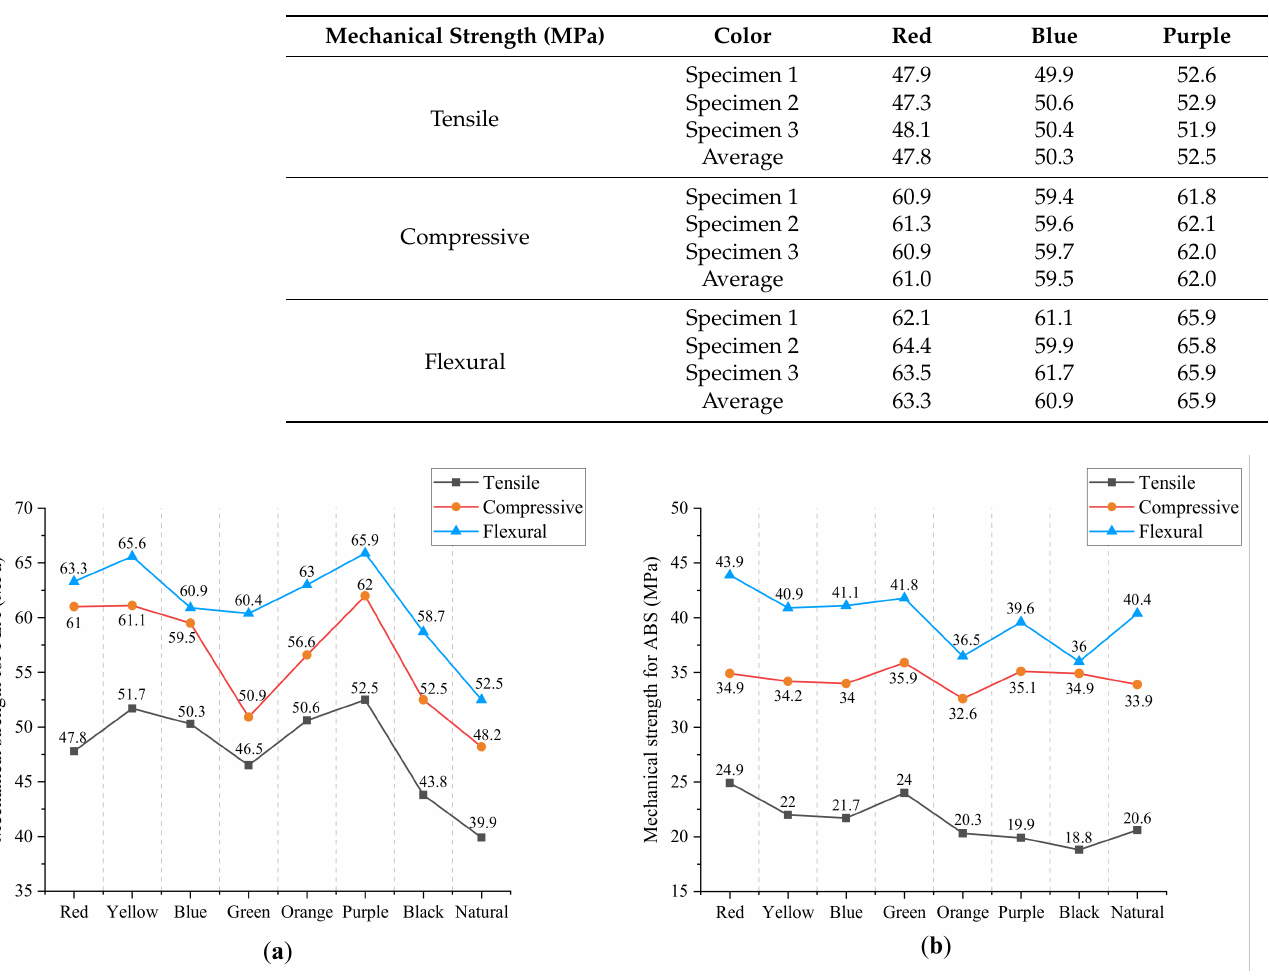
Table 3. Tensile strength data of PLA specimens in red, blue and purple color.